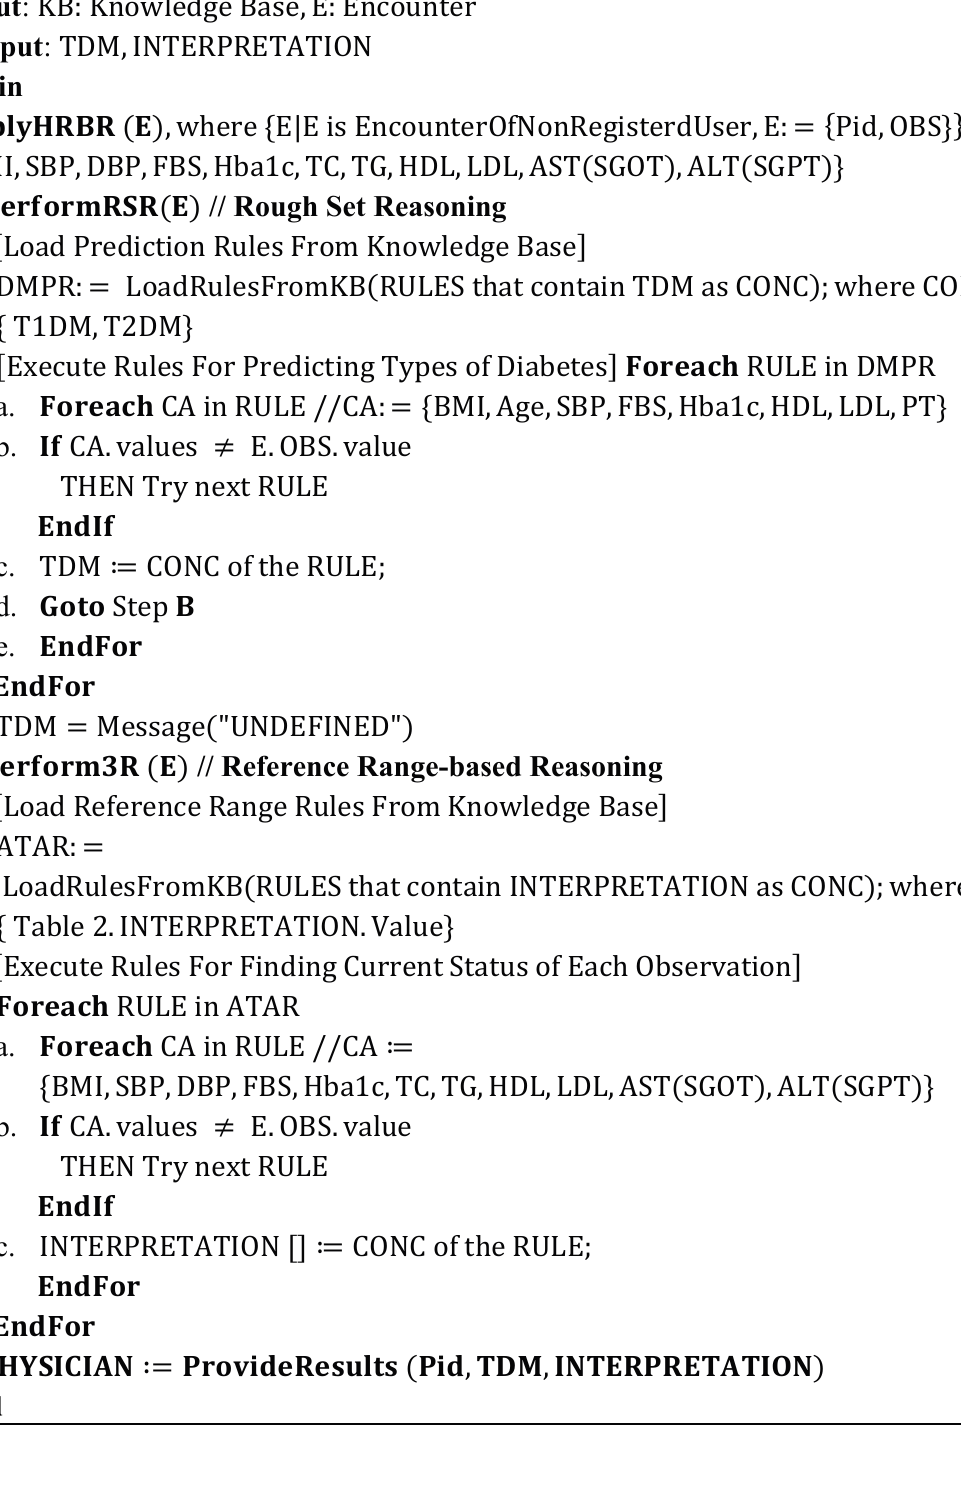
Algorithm 1 Hybrid Rule-based Reasoning (HRBR)